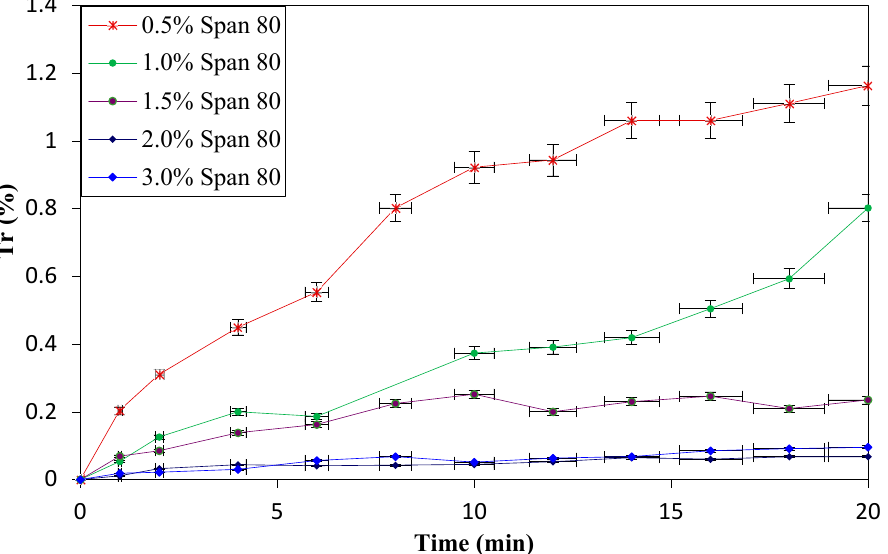
Figure 4. Effect of the Span 80 concentration on the emulsion stability ([Span 80]: [0.5–2] % wt./wt., w: 250 rpm, int/org ( v / v ): 1/1, emu/ext ( v / v ): 0.15/1, t emuls = 3 min, [HNO 3 Internal phase ]: 0,5M).